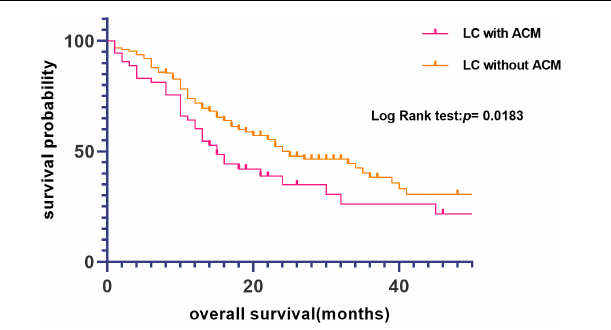
found that coexisting ACM was associated with worse OS (15 vs. 25) in patients with LC, who had higher D-dimer levels, lower serum calcium levels and lower LVEF values than the non-ACM patients. Together, these findings support that the comorbidity of ACM is associated with poorer survival in LC patients. However, we did not find that cancer-related IS was associated with ACM. These data highlight the need